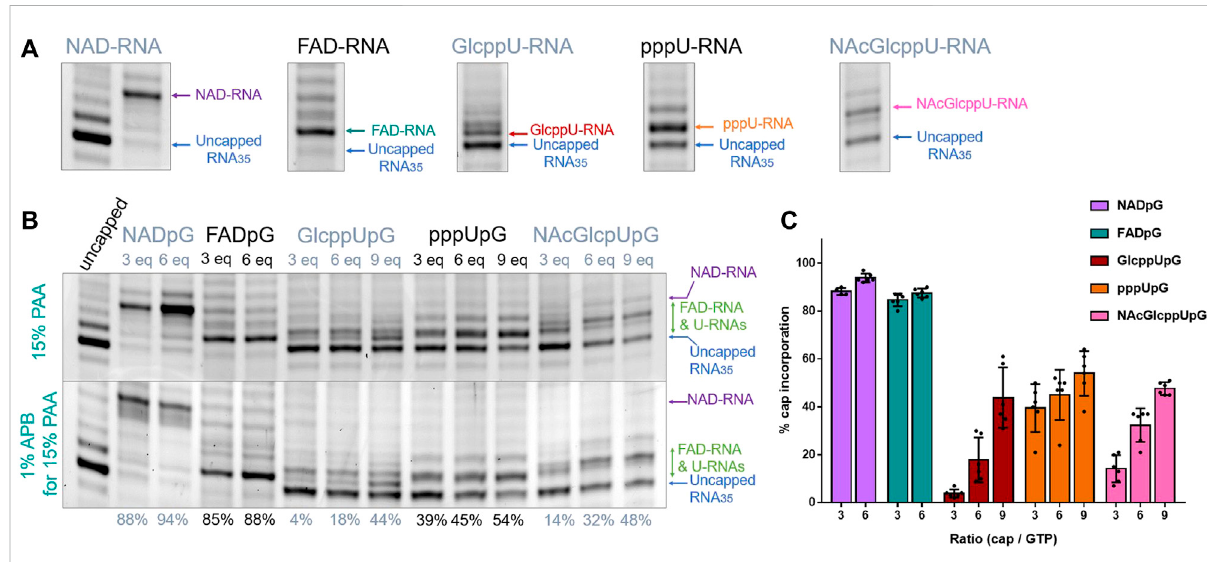
FIGURE 4 (A) HRPAGE (15% PAA, 7 M urea, 1 # TBE, SYBR Gold) analysis of differently capped RNA species with indication of bands used for capping ef fi ciency assessment. (B) Representative HRPAGE (15% PAA, 7 M urea, 1 # TBE, SYBR Gold), without APB (upper gel) or with 1% APB (bottom gel), of 25 ntIVTRNAobtainedfromatemplatewithG φ 6.5promoterafter3 ′ endtrimmingsteps.Thecappingef fi ciencyvaluesgivenbelowthegelindicate the mean values from triplicate analyses performed on three independent transcriptions and 6 densitometric measurements (+/- APB).